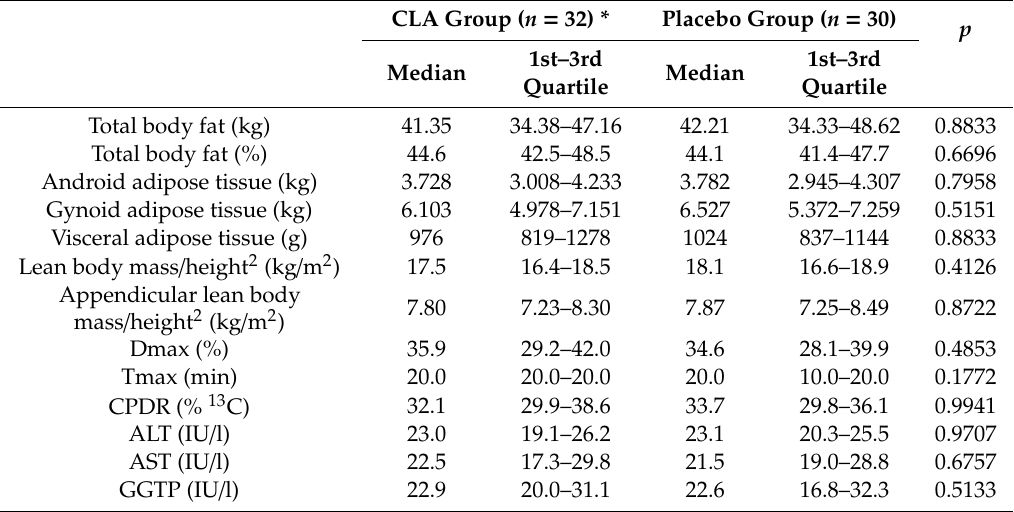
Table 2. Baseline characteristics of the studied